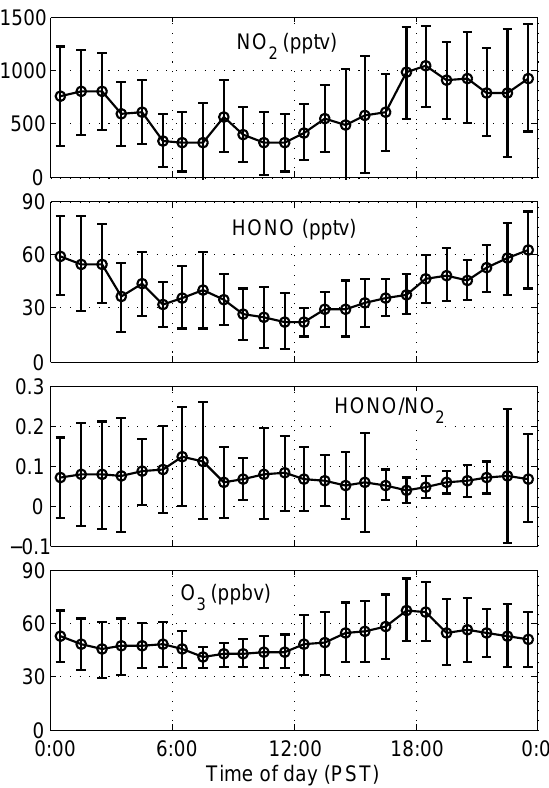
Fig. 6. Average diurnal profiles of O 3 , NO 2 , HONO, and HONO/NO 2 . HONO was measured at a height of 14m ( ∼ 6m above the canopy) by the wet chemistry HONO instrument and NO 2 was measured at a height of 12.7m. The data were collected be- tween 25 September and 10 October during BEARPEX2007. Error bars represent standard deviations in hourly bins.